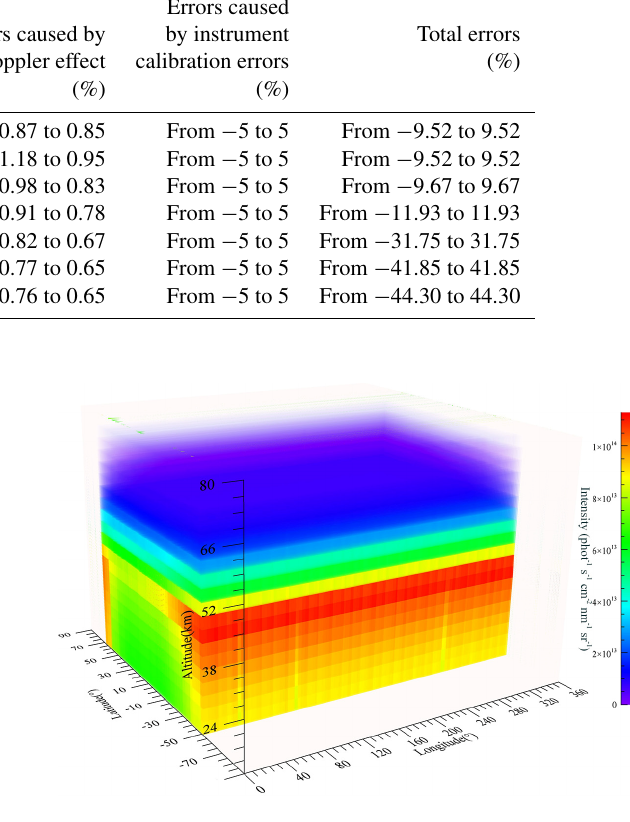
Figure 10. The simulated observation radiance received by SHS1 at the time of T1 under the different